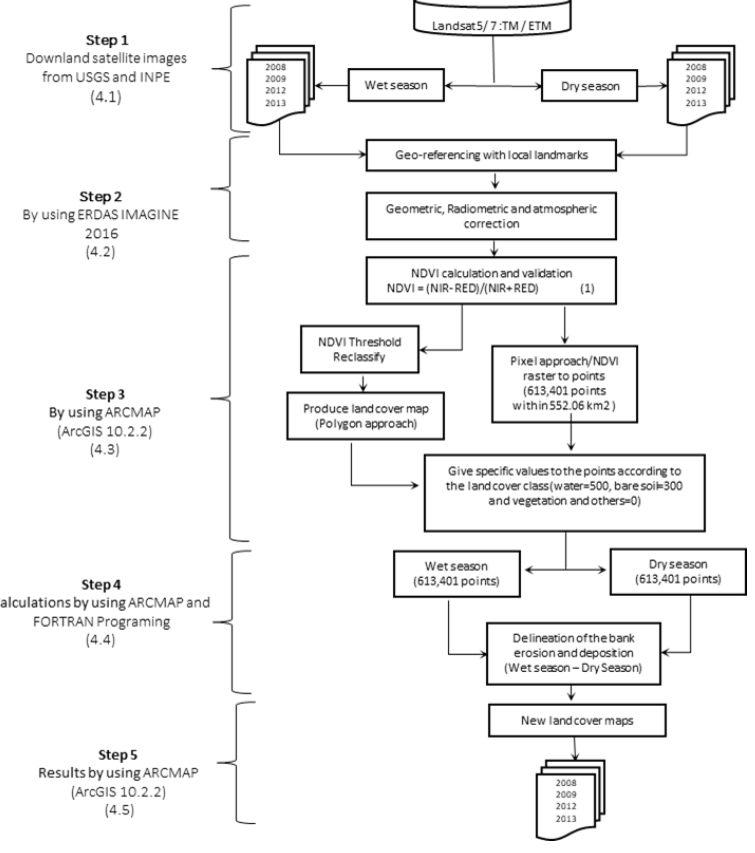
Figure 3. Flowchart of the methodology.